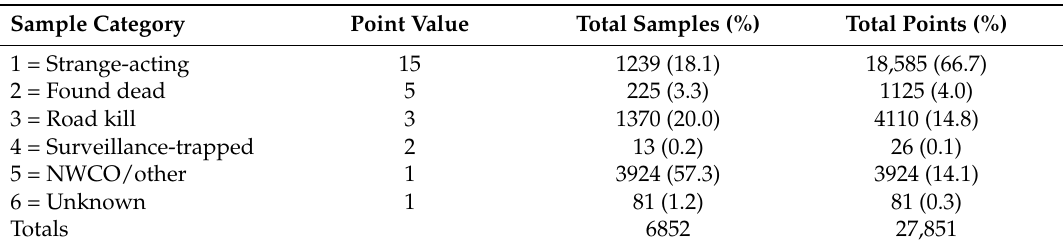
Table 3. Total enhanced rabies surveillance samples collected and tested by Wildlife Services, and total category points assigned, 1 January–31 December